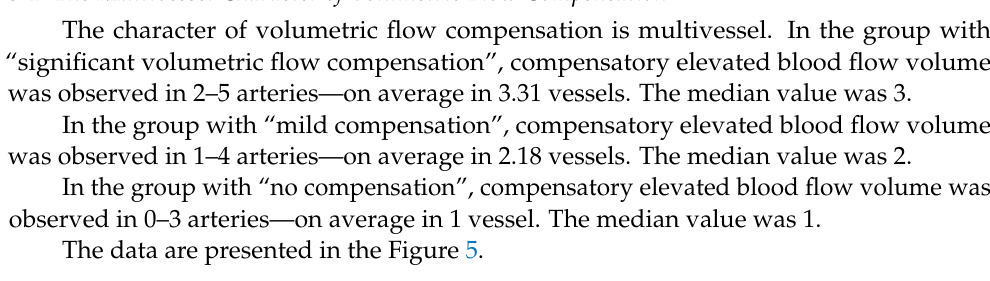
Figure 3. The percentage of the arteries with and without flow compensation in the whole study group. The compensatory increased flow volume was observed in 51.89% of VAs, 39.62% of ECAs, and 31.13% of ICAs.